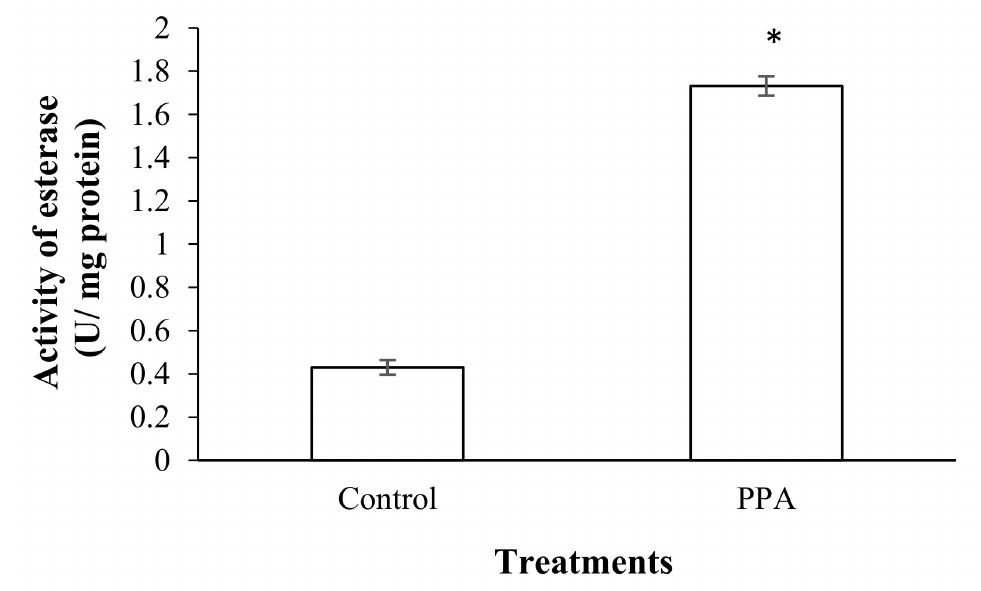
Figure 3. Activity of general esterase in control and PPA-treated adults of Sitophilus oryzae . Statistical differences have been marked by asterisks ( t -test, p ≤ 0.05). * indicate significant deference.